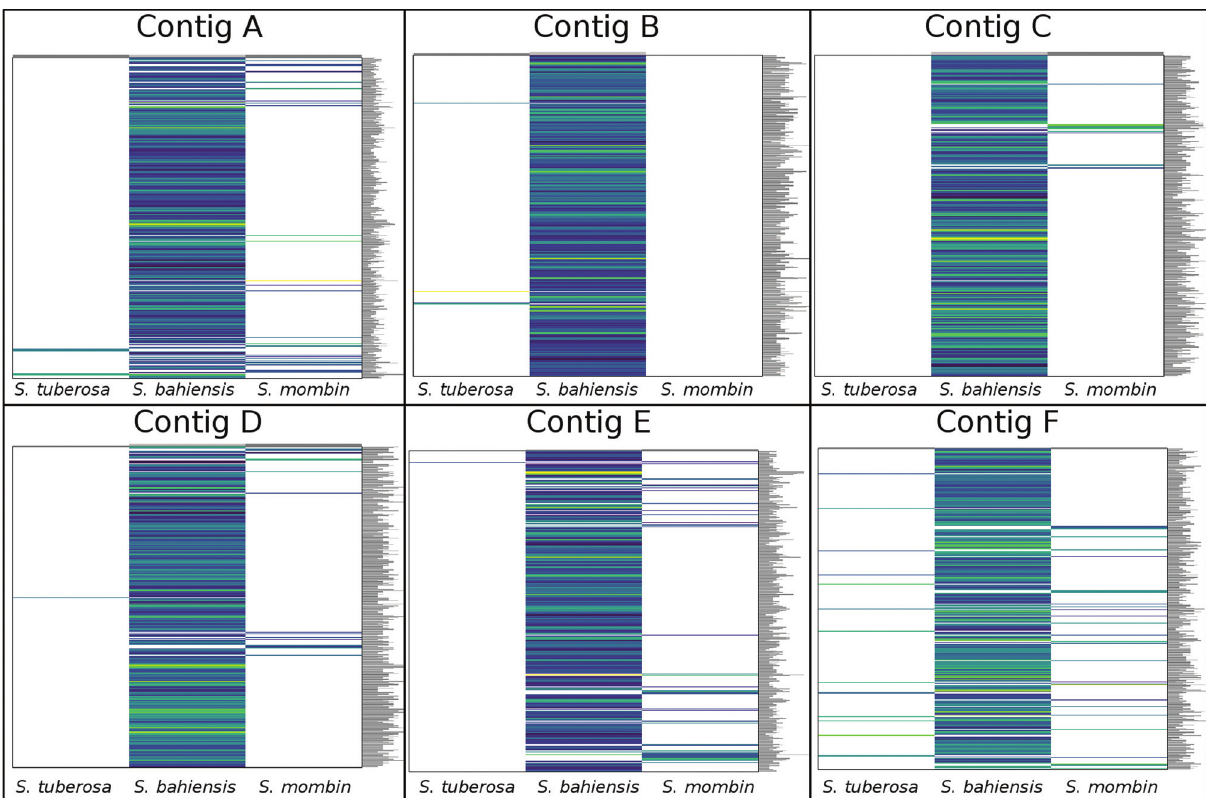
Figure 2 - SNP distribution and density of six contigs in Spondias tuberosa, Spondias bahiensis , and Spondias mombin .